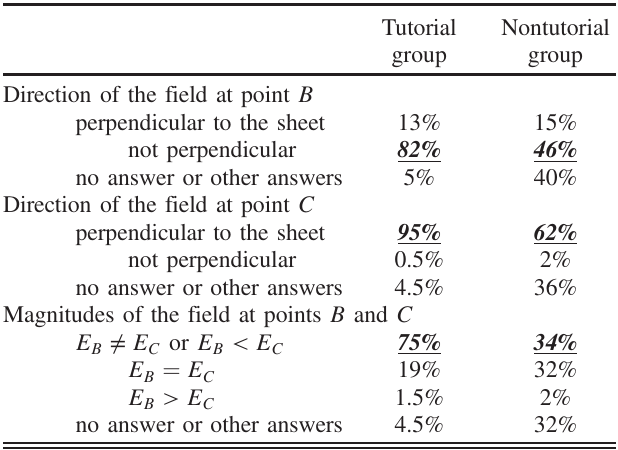
TABLE IV. Distribution of the student responses to post-test question (4) for the tutorial and nontutorial groups. The percent- ages of students who answered the questions correctly are in boldface and underlined.